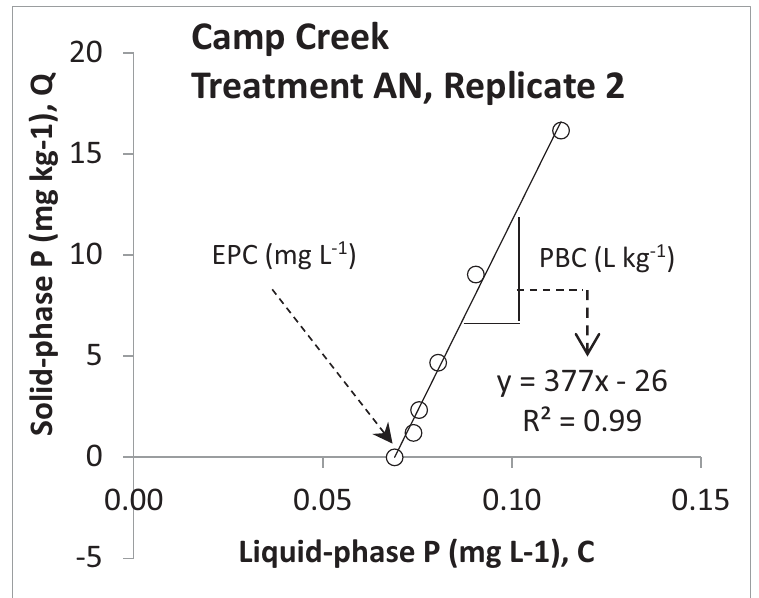
Fig 2. To determine phosphorus buffering capacity (PBC) and equilibrium phosphorus concentration (EPC) in the isotherm adsorption experiment the liquid phase P (C) was plotted against P in the solid phase (Q). This relationship is exemplified by one of the anaerobic treatments of Camp Creek